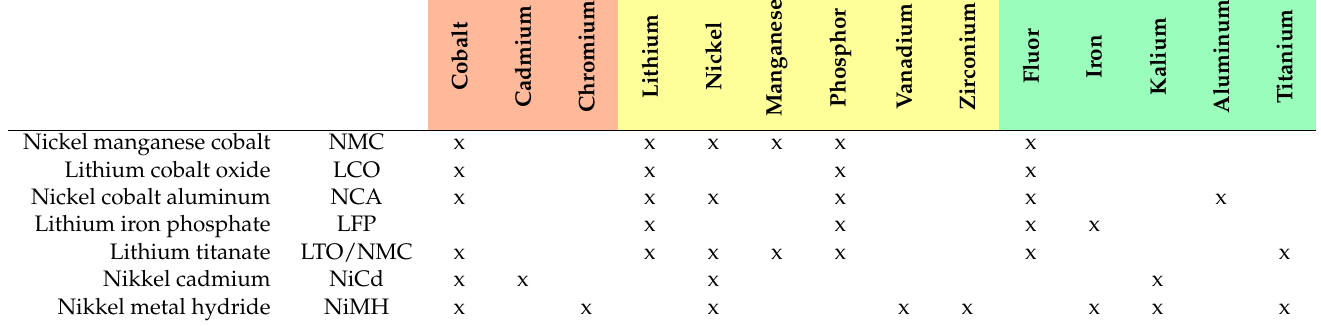
Table 7. Scarcity of elements used in battery production: elements with rising threat from increased use (orange), limited availability future risk to supply (yellow), and plentiful supply (green)